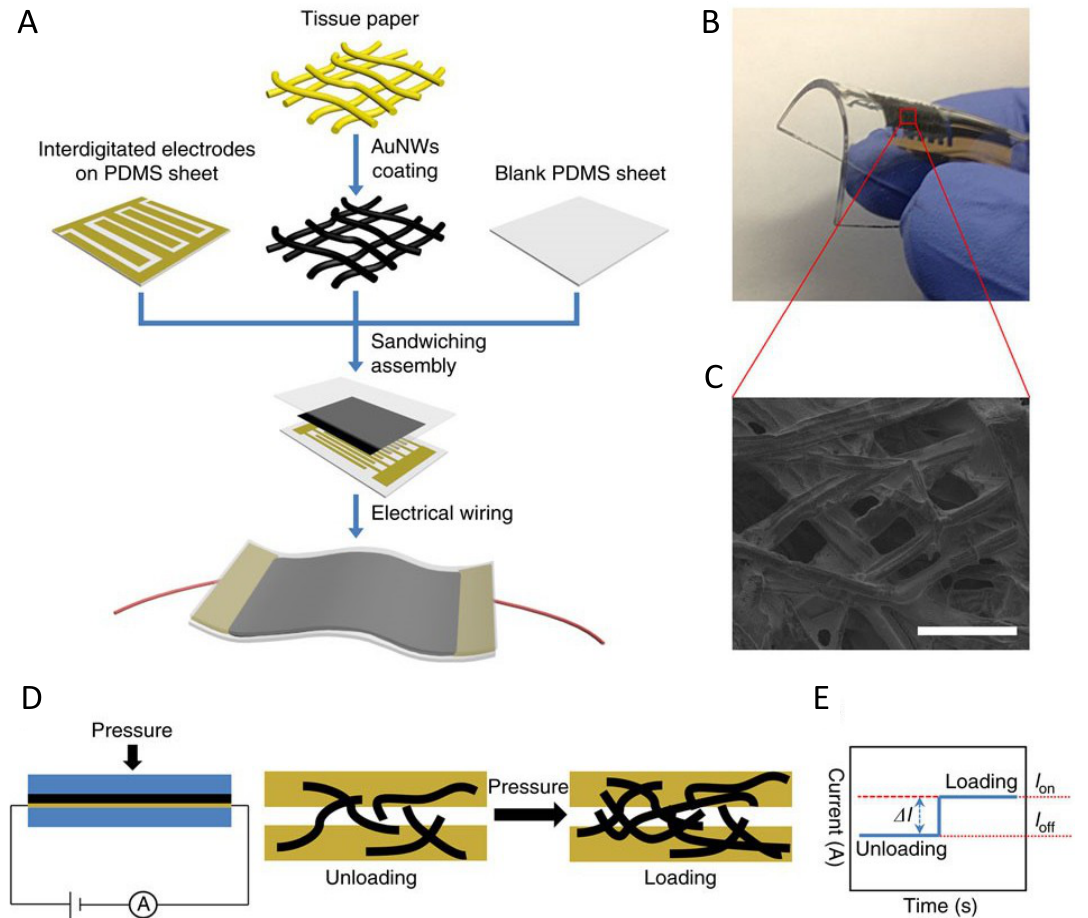
Figure 6. Pressure sensor based on the GNWs coated tissue paper. ( A ) Schematic illustration of the fabrication of a flexible pressure sensor; ( B ) photograph showing the bendability of the sensor; ( C ) scanning electron microscopy image of the morphology of gold nanowires coated tissue fibers (scale bar, 100 μm); ( D ) schematic illustration of